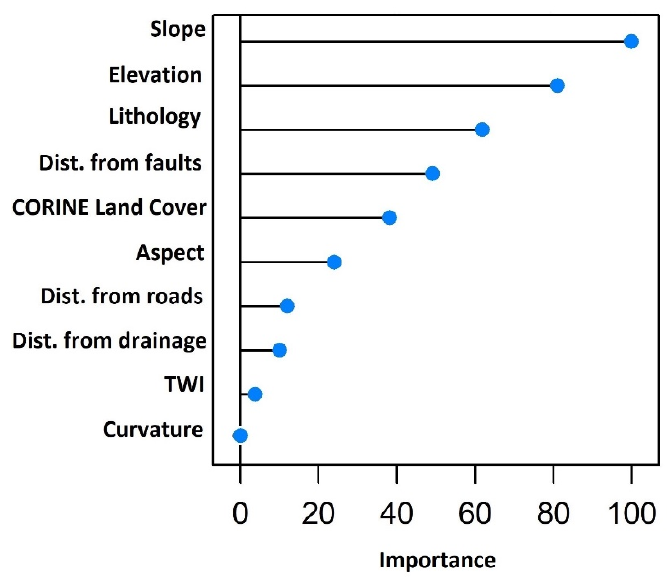
Figure 7. Importance of landslide conditioning factors.